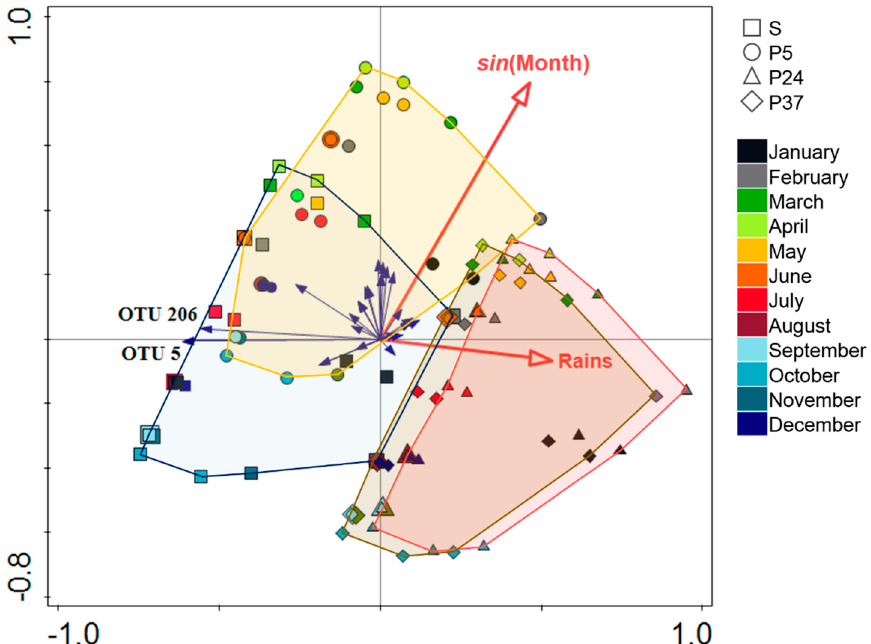
Figure 6. Redundancy analysis (RDA) triplot showing the relationships among the ST samples, the Enterobacteriaceae OTUs, and the environmental variables affecting the Enterobacteriaceae community. The first and the second axes explained 30.79% and 0.92% (F = 8.4, p = 0.001) of the variance in the Enterobacteriaceae community, respectively. The red arrows represent the variables sin (Month) and rains. The polygons enclose samples collected from the same site (light blue polygon: S samples; orange polygon: P5 samples; red polygon: P24 samples; brown polygon: P37 samples). The blue arrows represent OTUs; only the names of the two most abundant OTUs are